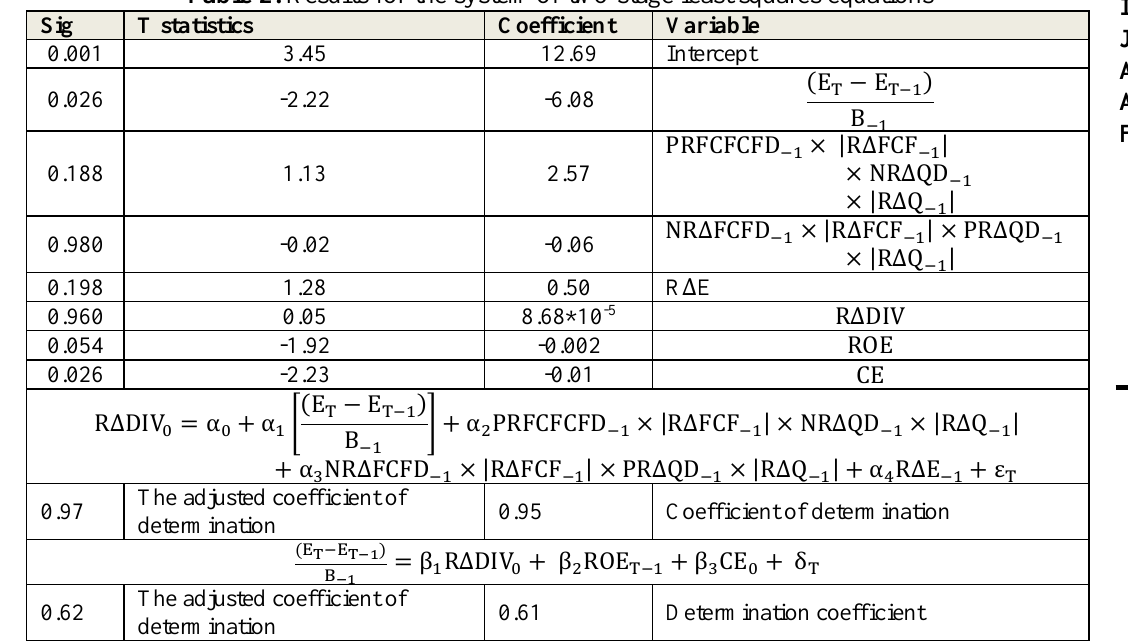
Table 2. Results for the system of two-stage least squares equations